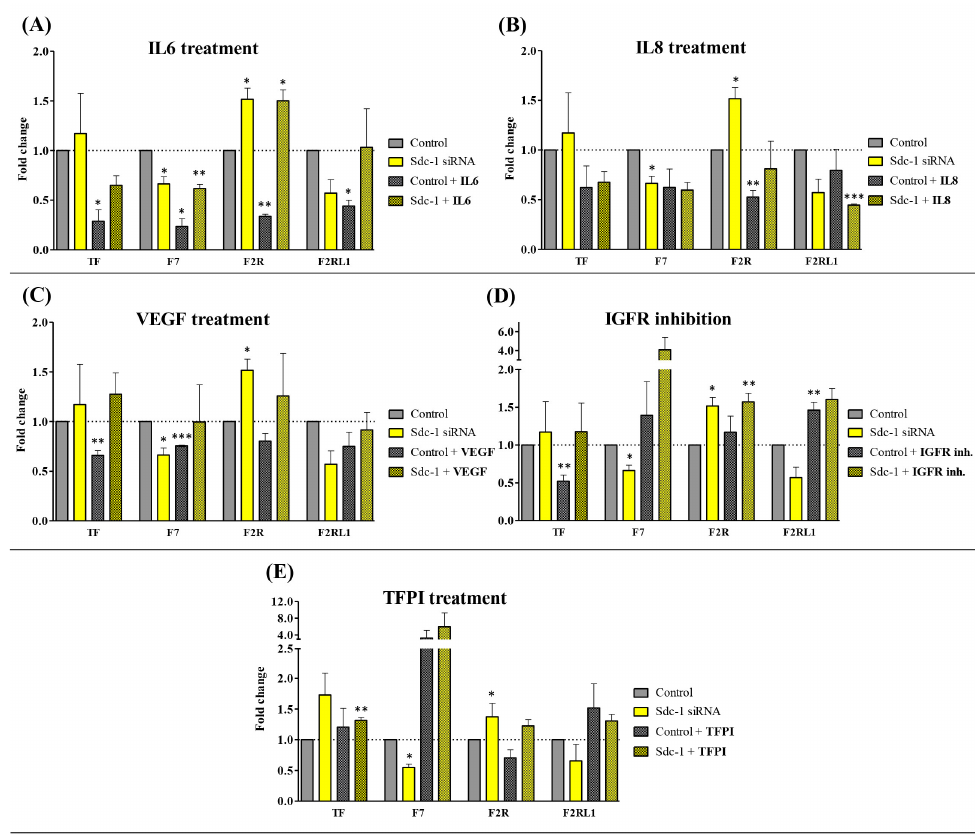
Figure 1. Sdc-1-KD modulates cytokine-dependent tissue factor (TF) pathway gene expression in MDA-MB-231 breast cancer cells. The expression of TF pathway-associated genes was analyzed post-transfection and 24 h after treatment with exogenous ( A ) IL6 (100 ng/mL), ( B ) IL8 (100 ng/mL), and ( C ) VEGF (20 ng/mL) and with ( D ) the inhibition of IGFR with AG-1024 (20 µM) and ( E ) TFPI (50 ng/mL) by means of qPCR, normalized to β -actin expression and shown as a fold change (n = 3). Data are presented as bar plots and means are represented with lines. Bars with asterisks represent comparisons with statistically significant differences (* p < 0.05, ** p < 0.01, *** p < 0.001).